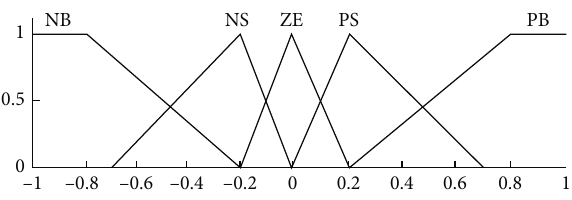
Figure 7: Membership function of yaw rate change